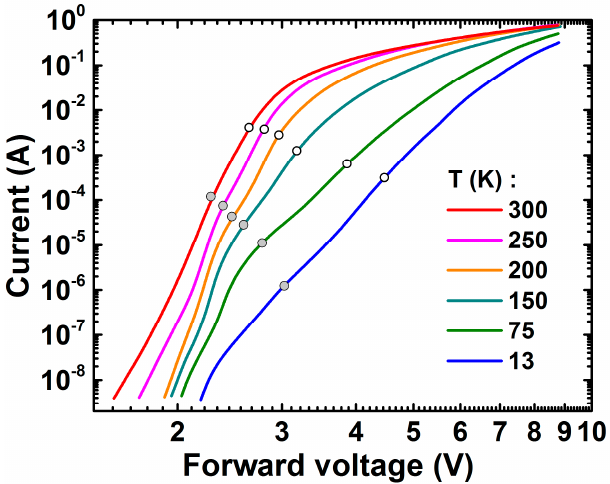
Figure 1. Current–voltage characteristics of the green LED measured at various temperatures. Closed and open circles indicate points at which shorter-wavelength and longer-wavelength emission approaches their maximum efficiency (see Section 2.4 for more details).